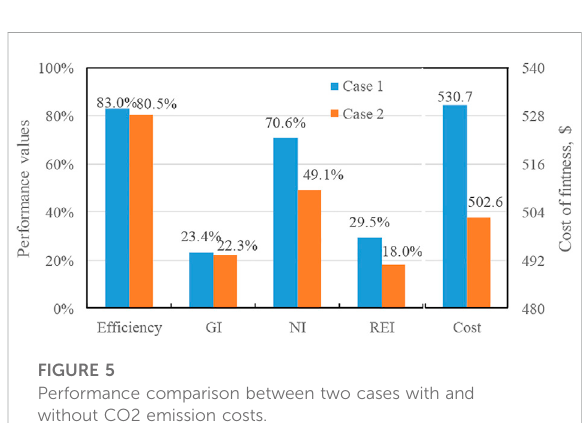
FIGURE 5 Performance comparison between two cases with and without CO2 emission